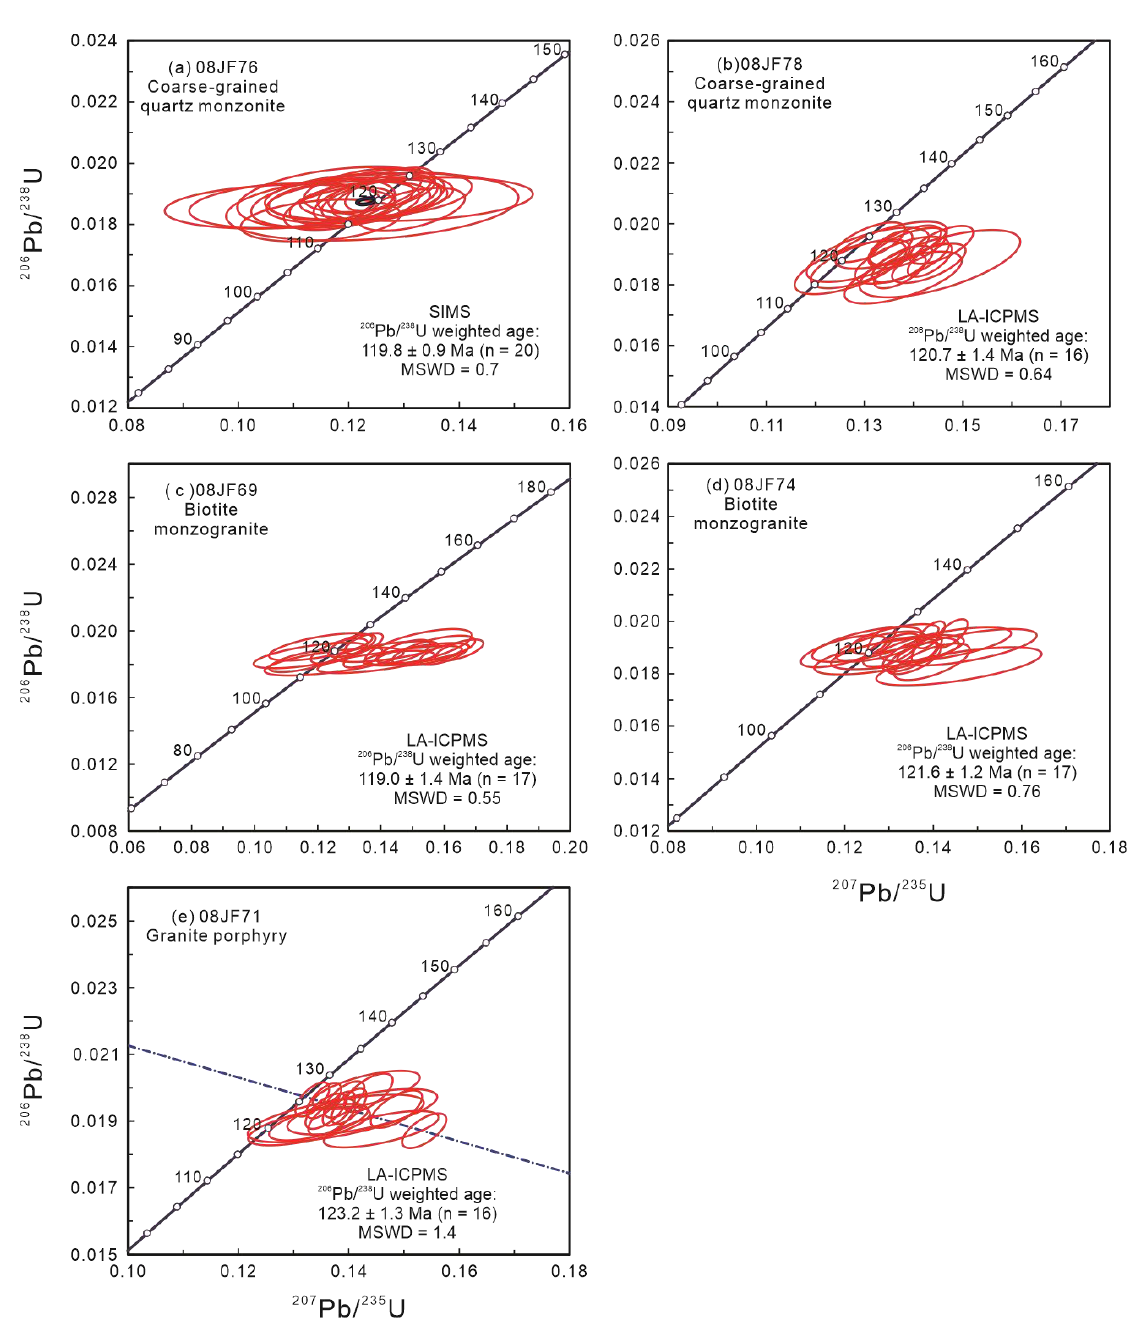
Figure 4. Concordia diagrams of the zircon U-Pb age data obtained via the SIMS and LA-ICP-MS methods for the ( a , b ) coarse-grained quartz monzonite, ( c , d ) biotite monzogranite, and ( e ) granite porphyry in the Yushulinzi pluton. The analytical technique, weighted average age, and MSWD are reported. The CL images show that the zircons from the granite porphyry (08JF71) are short prismatic crystals (Figure 3c), and they have Th/U ratios of 0.4–1.1. Sixteen analyses of zircons dated using the LA-ICP-MS zircon U-Pb method yielded a weighted mean 206 Pb/ 238 U age of 123.2 ± 1.3 Ma (2 σ , n = 16) (Figure 4e), which is interpreted as the age of crystallization for the granite